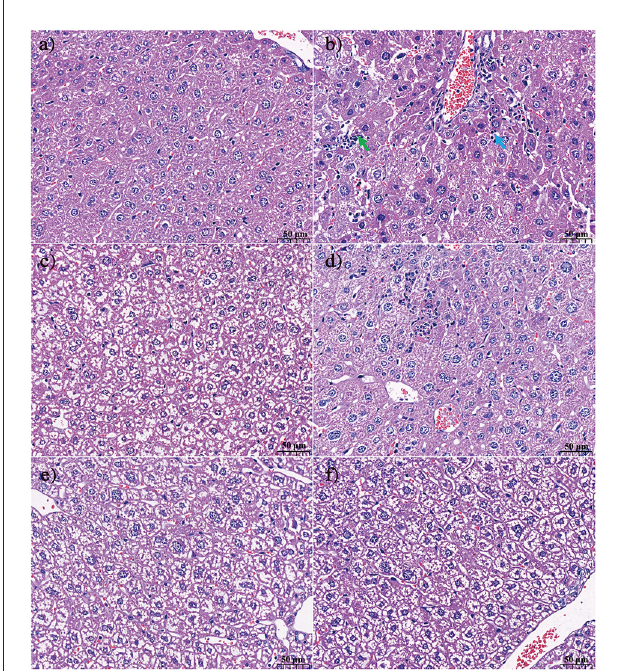
FIGURE3 The effect of KFP on the histological examination of liver in the AA induced mice with H&E (a) CK, (b) AM, (c) KFP-L, (d) KFP-M, (e) KFP-H, (f) APS (magnification × 400). Green arrow repersents hepatocyte necrosis and blue arrow represents lymphocytes. CK, control group; AM, acrylamide model group; KFP-L, low-dose KFP group; KFP-M, medium-dose KFP group; KFP-H, high-dose KFP group;